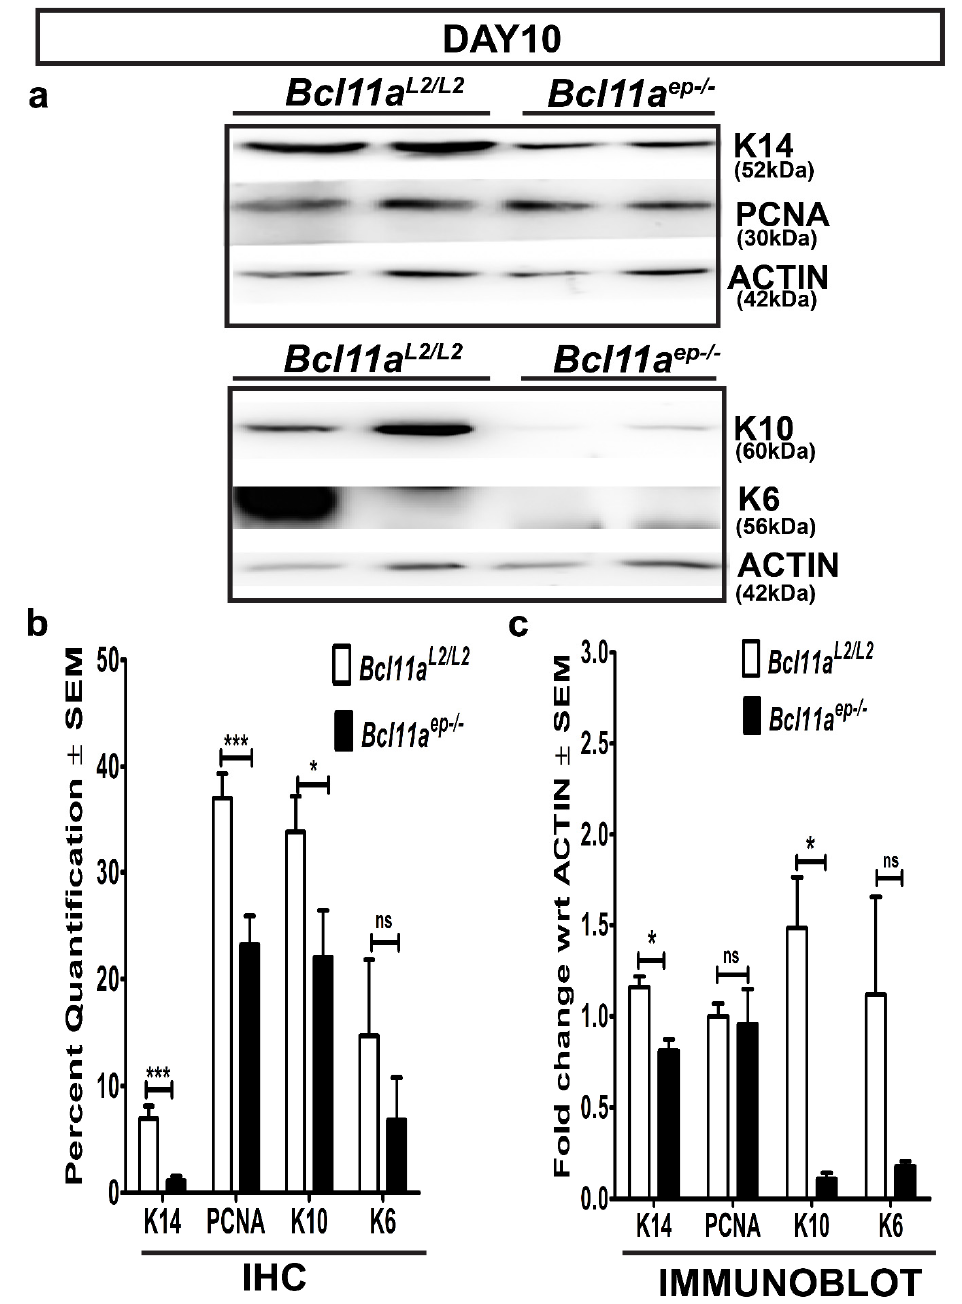
Figure 8. Epidermis specific Bcl11a deletion restores expression profile of epidermal markers to physiological levels on Day 10 post wounding. ( a ) Immunoblot analyses of basal keratinocyte marker (K14), active proliferation marker (PCNA), activated keratinocyte marker (K6), and early differentiation marker (K10) expression in the dorsal skin of Bcl11a L2/L2 versus Bcl11a ep − / − adult mice on Day 10 post wounding. β -actin was used as the internal control. ( b ) IHC quantification displaying the Day 10 post wounding expression status of epidermal markers (K14, PCNA, K10 and K6) in Bcl11a L2/L2 versus Bcl11a ep − / − mice. ( c ) Immunoblot quantification showing the relative fold change in the expression status of epidermal markers (K14, K10 and K6) in Bcl11a L2/L2 versus Bcl11a ep − / − Day 10 wounds. N = 4, where N represents the number of animals of each genotype ( Bcl11a L2/L2 or Bcl11a ep − / − ) being involved in the study. Western blots were repeated 2–3 times. * p < 0.1, *** p < 0.001, ns <